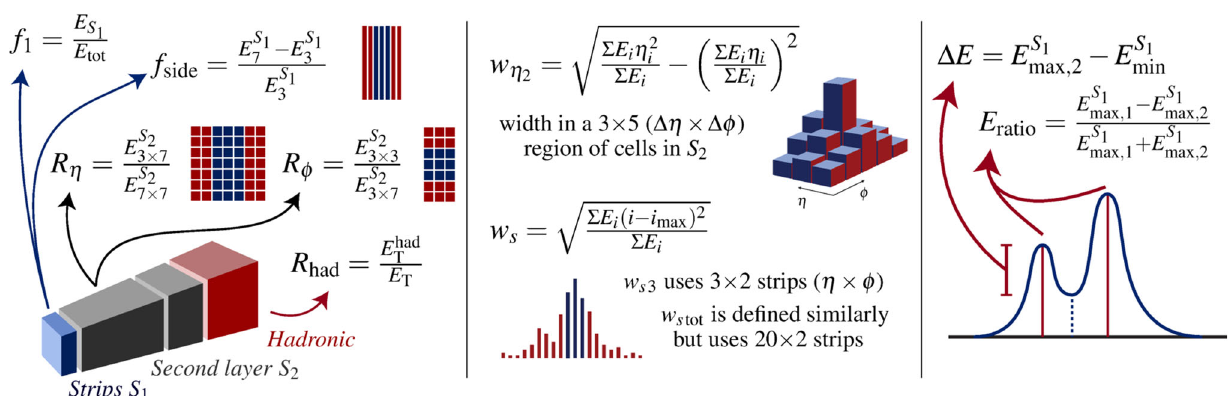
Fig. 2 Schematic representation of the photon identification discrim- calorimeter in a cluster of properties C , identifying the number and/or properties of selected cells. E i is the energy in the i -th cell, η i the identify the electromagnetic inating variables, from Ref. [23]. E S N C pseudorapidity centre of that energy collected in the N -th longitudinal layer of the electromagnetic